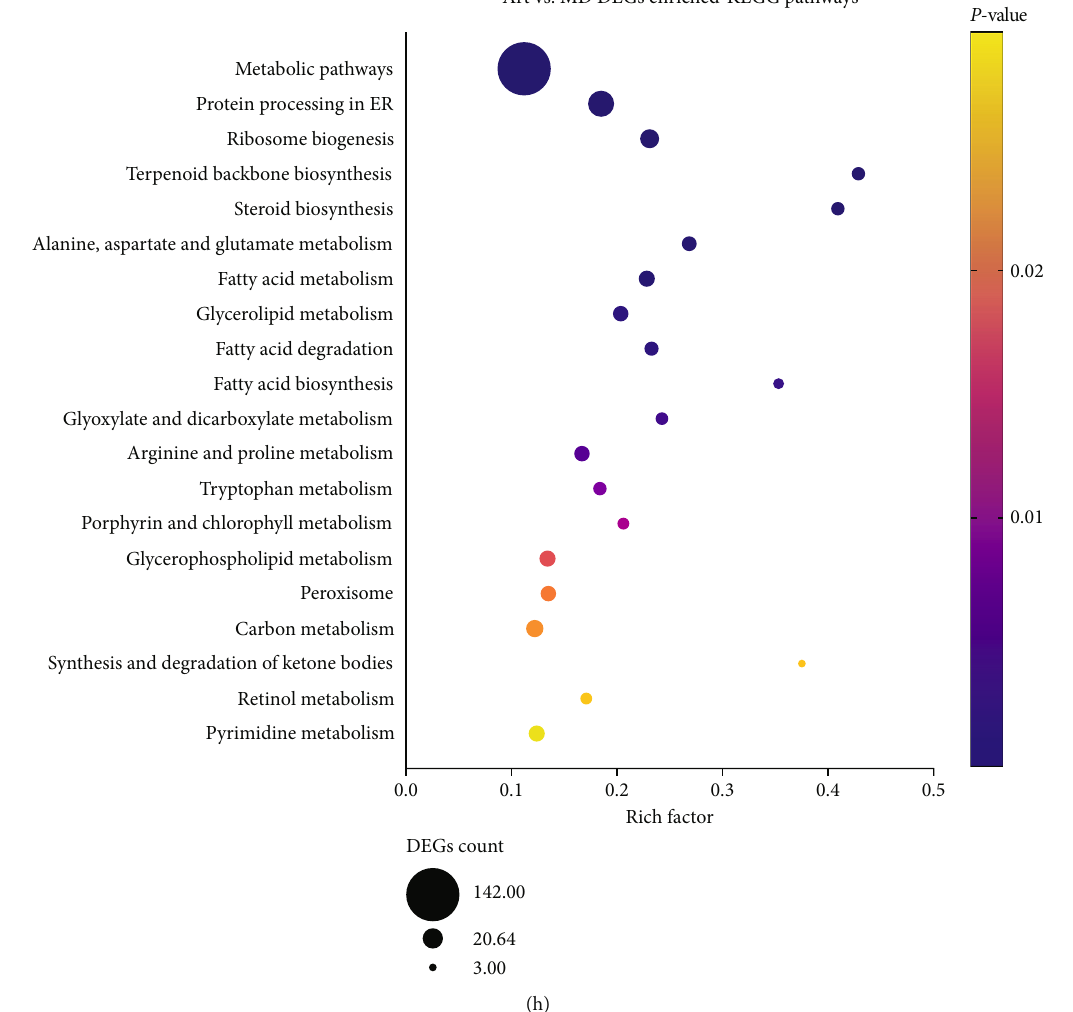
Figure 2: Transcriptome analysis of larval liver tissue. (a) Pearson ’ s correlation between samples. (b) PCA of samples. (c) Number of DEGs presented in a Venn diagram. (d) Volcanic map of detected gene expression levels between the art and MD groups. (e) Heat map presentation for partial DEGs between treatments. (f) UMI-RNA-seq DEG validation by qRT – PCR. (g, h) DEGs enriched GO and KEGG pathways between